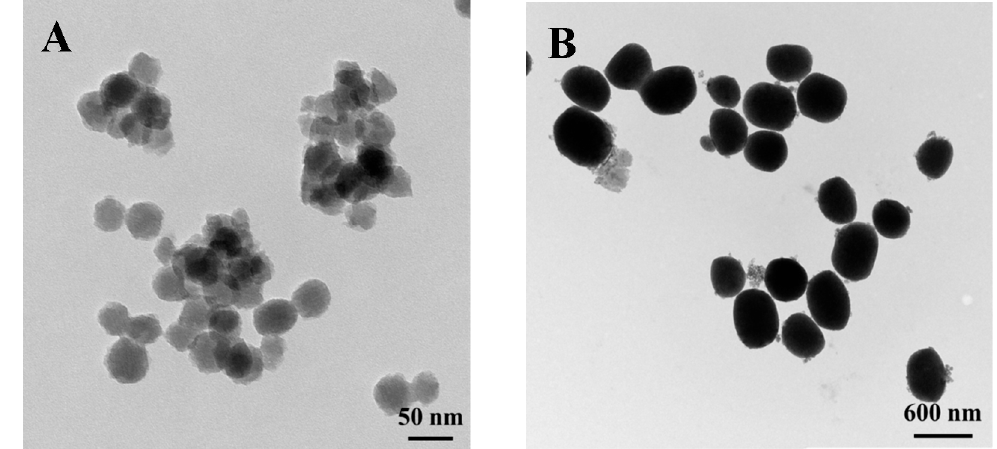
Figure 1. TEM images of tetracycline-containing MCM-41 nanoparticles. ( A ) TC-MCM-41A (41 ± 4 nm) and ( B ) TC-MCM-41B (406 ± 55 nm).